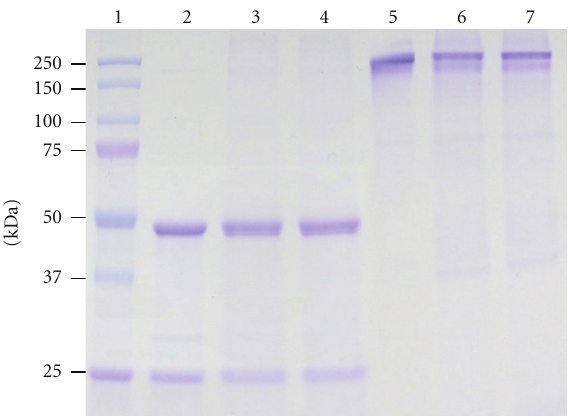
Figure 3: Purification of E16 mAbs produced in lettuce or N. benthamiana . Purified E16 mAbs were analyzed on a 12% SDS- PAGE gel using either reducing (Lanes 2–4) or nonreducing (Lanes 5–7) sample bu ff er. Lane 1: Molecular weight marker; lanes 2 and 5: mammalian cell-derived E16 as reference standard; lanes 3 and 6: E16 purified from lettuce leaves; lanes 4 and 7: purified E16 from N. benthamiana. One representative of several independent experiments is